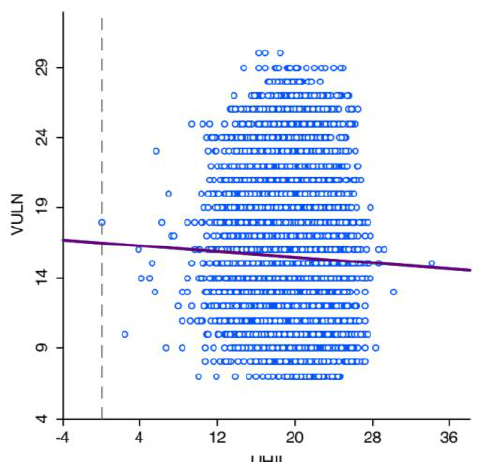
Figure 11. Scatterplot of maximum UHII versus vulnerability index for Dallas.